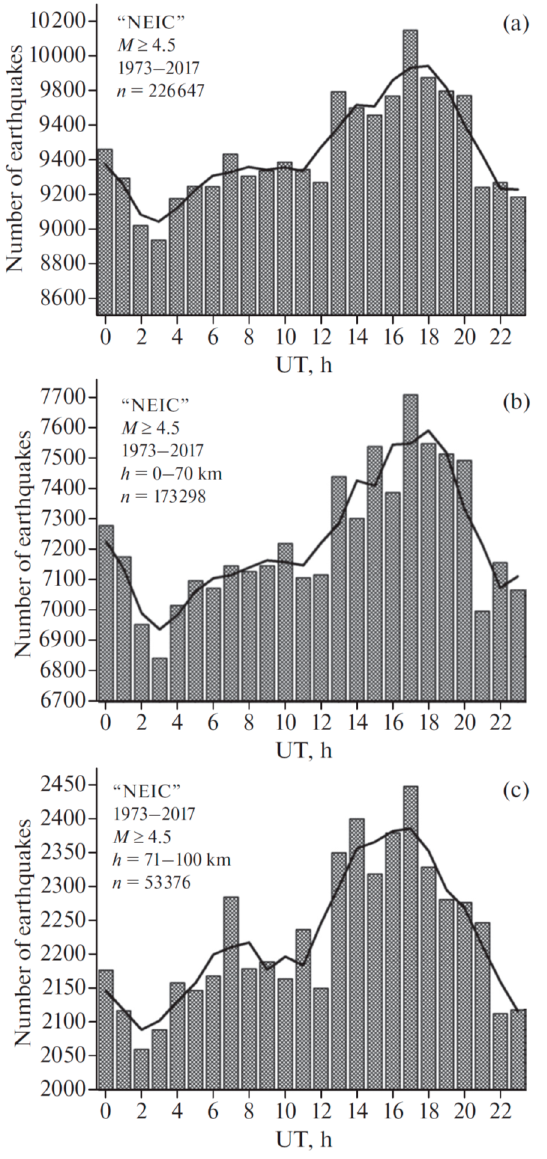
Figure 6. Histograms of distributions by 1-h UT intervals of the number of earthquakes with a magnitude of М ≥ 4.5 recorded on the planet from 1973–2017; the black curves show the 3-h moving average for ( a ) earthquakes of all depths (226,674 events), ( b ) earthquakes with hypocenter depths of up to 70 km (173,298 events), and ( c ) earthquakes with a hypocenter depth of 71–700 km (53,376 events).